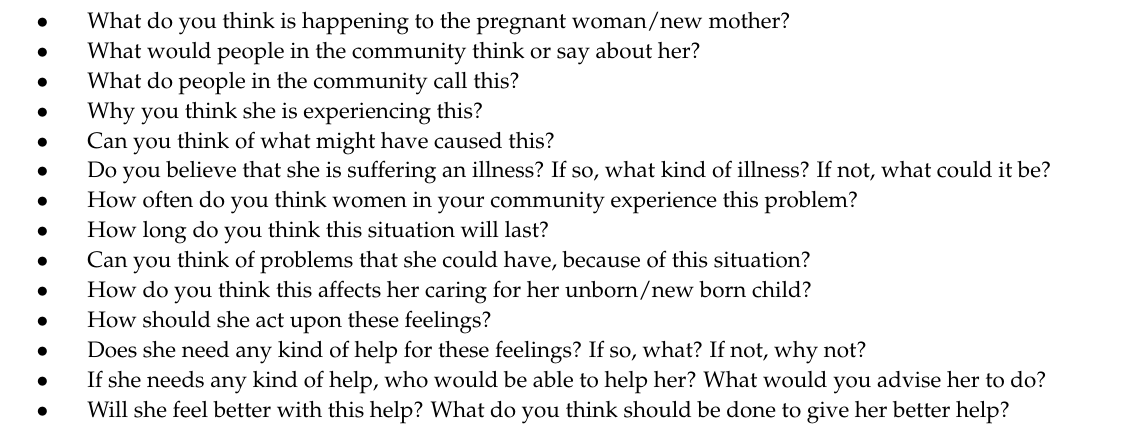
Table 2. Tentative IDI and FGD question